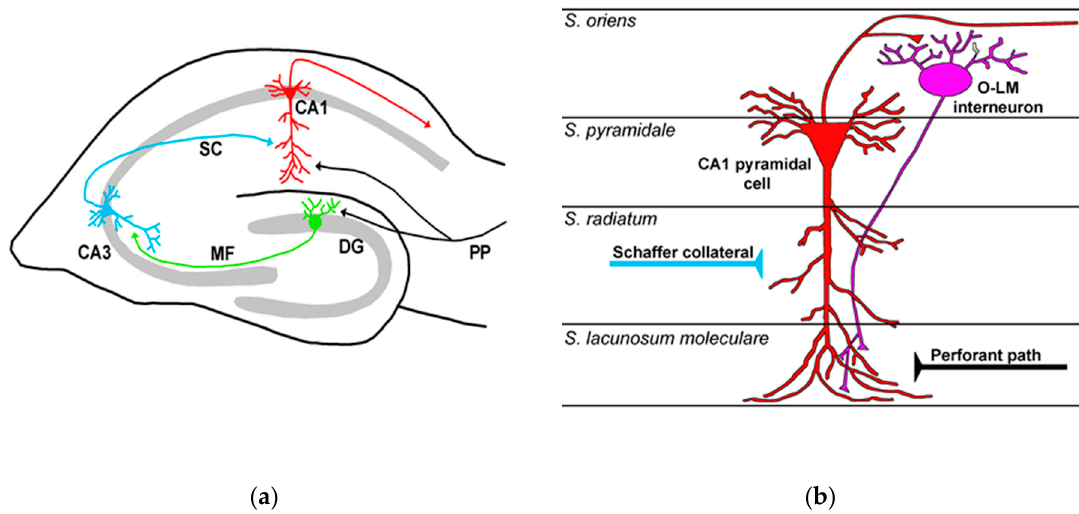
Figure 2. Hippocampal circuitry: ( a ) Signals from the entorhinal cortex (not shown) enter the hippocampus through the perforant pathway (PP) fibers, which make excitatory synapses on CA1 pyramidal neurons (red) and onto granule cells (green) of the dentate gyrus (DG). Granule cells make excitatory synapses via mossy fibers (MF) with CA3 pyramidal cells (light blue). The latter excite CA1 pyramidal cells via the Schaffer collateral (SC) pathway. The axons of CA1 pyramidal cells project to other brain structures, such as the subiculum (not shown). ( b ) Schematic drawing of a CA1 somatostatinergic microcircuit involving an oriens lacunosum-moleculare (O-LM) interneuron. This neuron projects to the stratum lacunosum-moleculare, making synaptic contacts with the distal dendritic tree of pyramidal neurons. O-LM interneuron is mainly activated by local axon collaterals of CA1 pyramidal cells when Schaffer collateral activity drives this cell to its firing threshold.